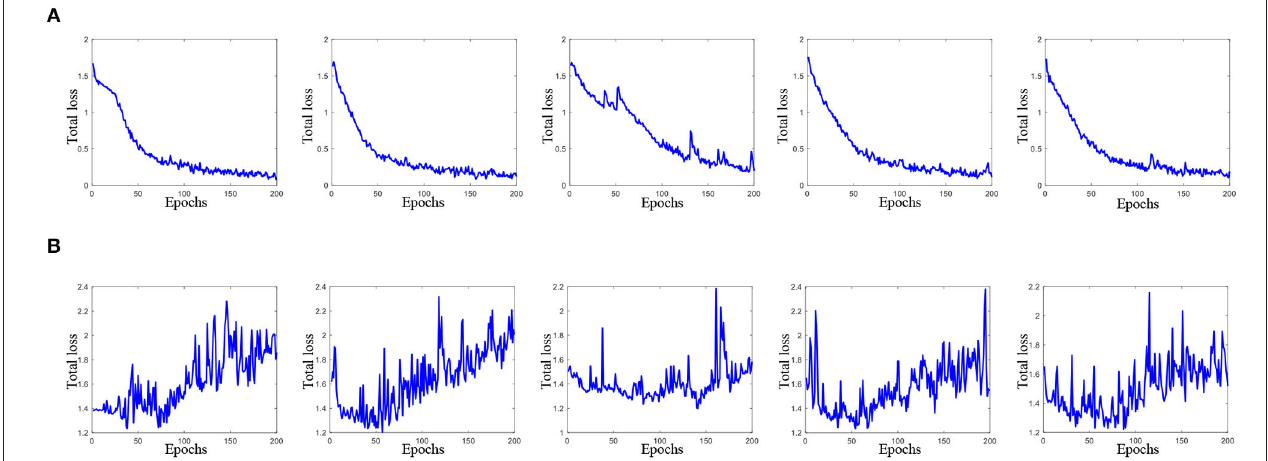
FIGURE 3 | Total loss of the proposed method with 200 epochs in each fold cross-validation (from left to right) for AD vs. lMCI vs. eMCI vs. NC classification task. Here, (A) total loss of training data, and (B) total loss on validation